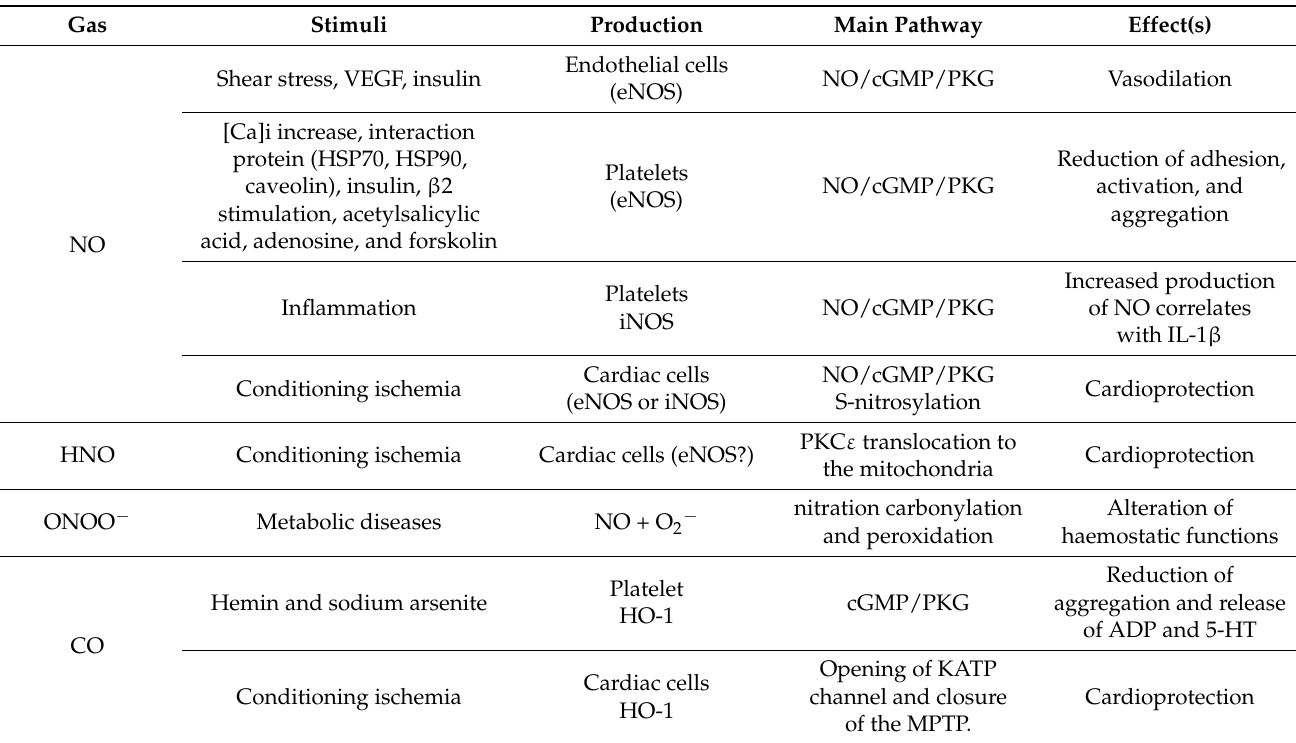
Table 1. The main stimuli and pathways involved in nitric oxide (NO) and carbon monoxide (CO)-induced effects on platelets. Abbreviations: eNOS endothelial nitric oxide synthase; iNOS inducible nitric oxide synthase; HO-1 heme oxygenase 1; cGMP cyclic guanosine monophosphate; HNO Nitroxyl; PKG protein kinase cGMP-dependent; IL-1 β interleukin-1 β ; PKC protein kinase C; ONOO −